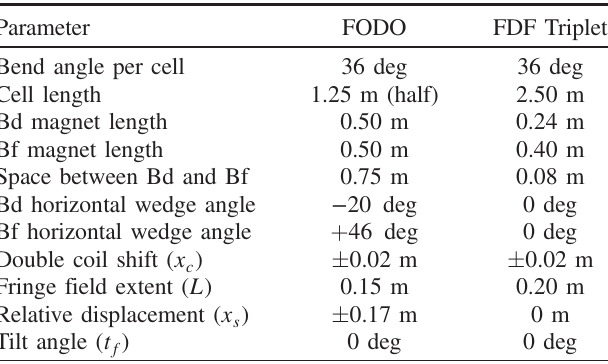
TABLE II. Geometrical parameters of FODO and FDF triplet focusing lattices. Magnets were placed symmetrically about the center of each side of the polygon.